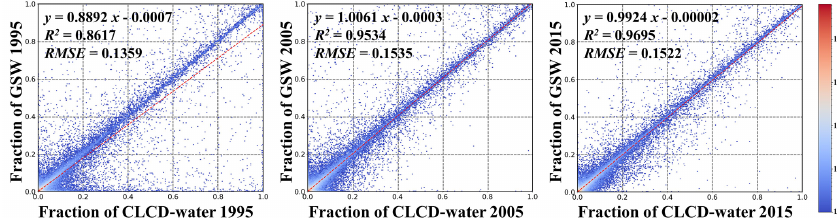
Figure 10. Scatterplots of surface water fraction between CLCD and GSW in 1995, 2005 and 2015, respectively. Water fraction was aggregated within the 0.05 ◦ by 0.05 ◦ spatial